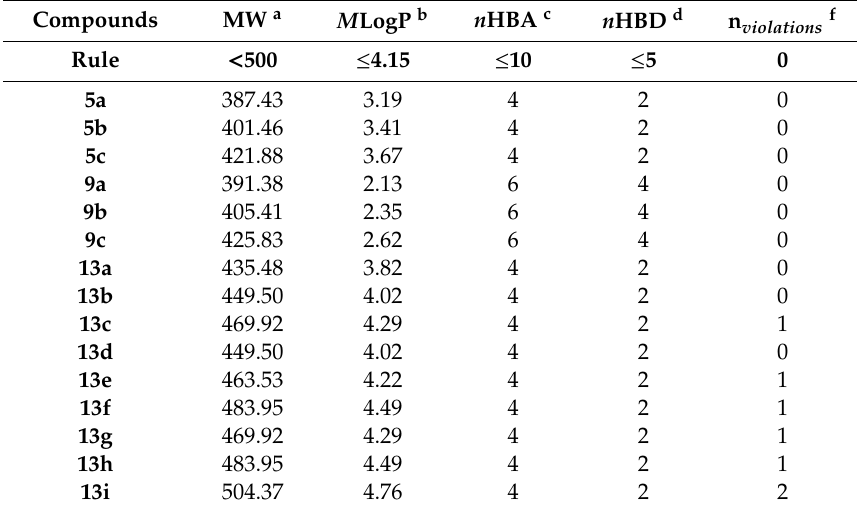
Table 4. Lipinski’s rule of five for the compounds pyrazolo[1,5- a ]pyrimidines 5a – c , 9a – c and 13a – i . Compounds